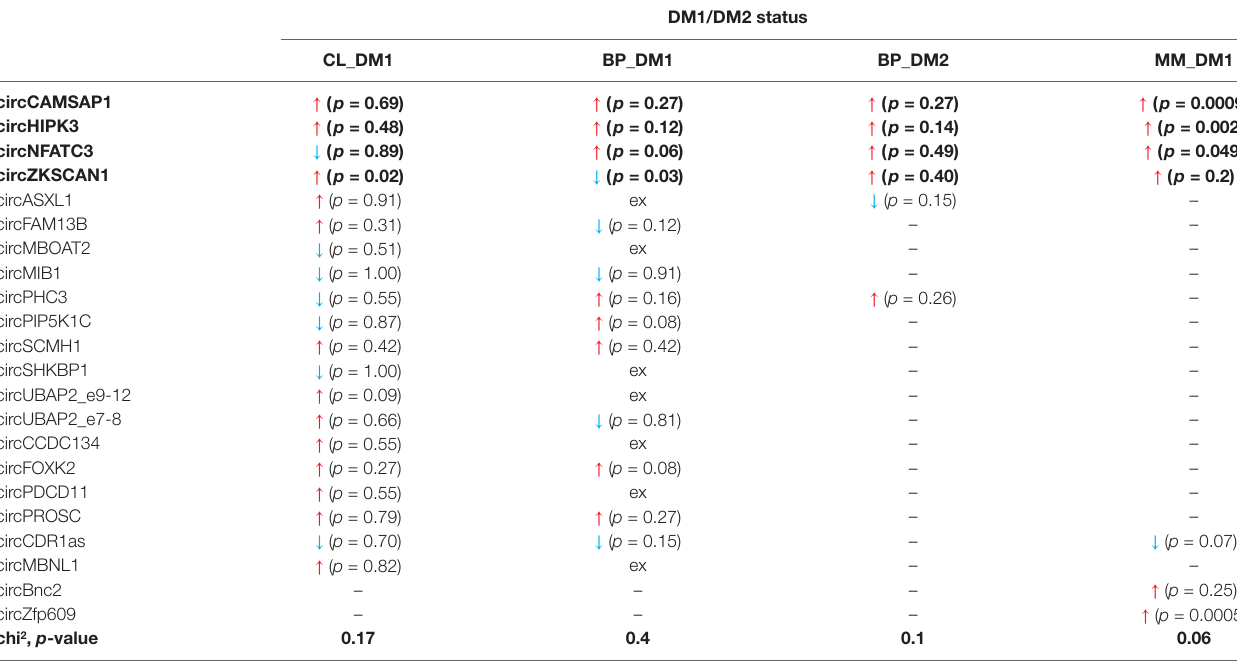
TABLE 3 | Results of experimental analyses of circRNA expression